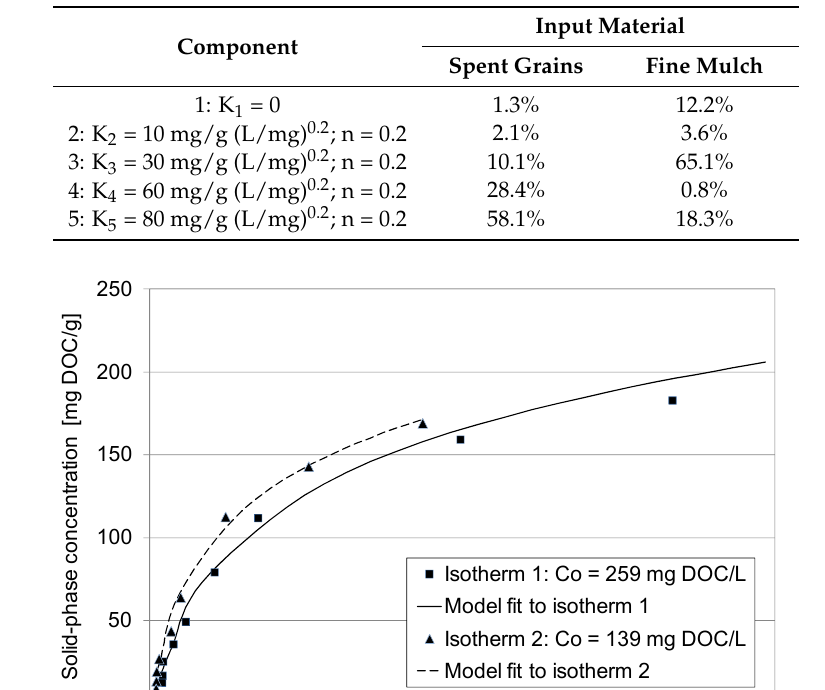
Figure 3. Overall isotherms of pre-treated HTC fine mulch PW and fit of the IAST model. The effective diffusivities D L,eff derived from short fixed-bed column tests are given in Table 4. They differ by a factor of 3.8, indicating a significant difference in molecular size. This is illustrated